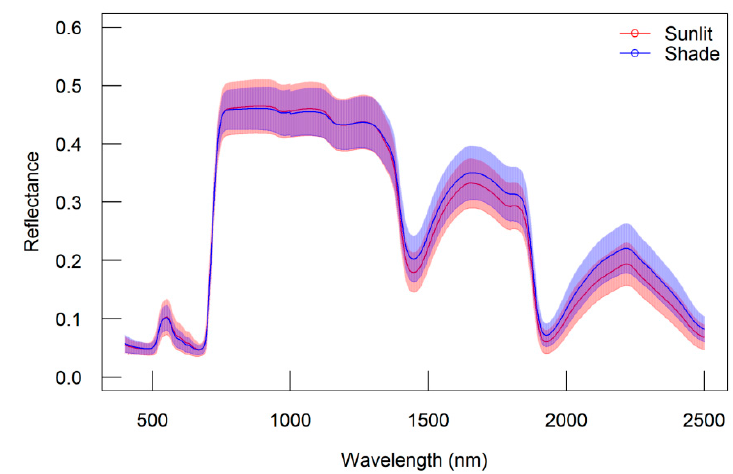
Figure 5. Variation of reflectance based on leaf categories. Lines represent mean of reflectance and the opaque zones represent standard deviations.